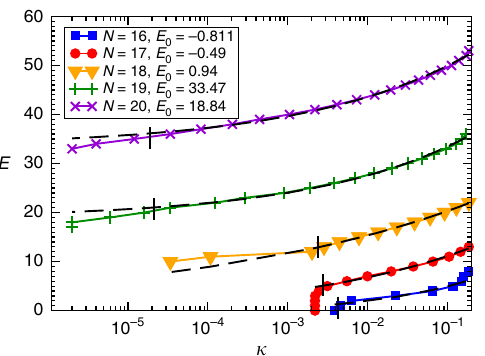
Fig. 6 Finding the Ramsey number R (4, 4). The E ( κ ) relationship for the 6- SAT problems corresponding to the K N complete graph colorings with two colors. E 0 is the extrapolated value based on the fi t from Eq. (5) (dashed lines). The long vertical bars indicate the lower end of the fi tting range. Note that for N = 16, 17, E 0 is a negative value indicating full colorability (the corresponding 6-SAT problem is fully satis fi able), whereas for N ≥ 18, E 0 > 0, and thus the 6-SAT problem becomes edges. We are satis fi ed with a coloring (a solution) when no m - clique is monochromatic, i.e., every m -clique with set of edges { i 1 , … , i m ( m − 1)/2 } must have both colors, expressed as the statement formed by the conjunction of the two clauses